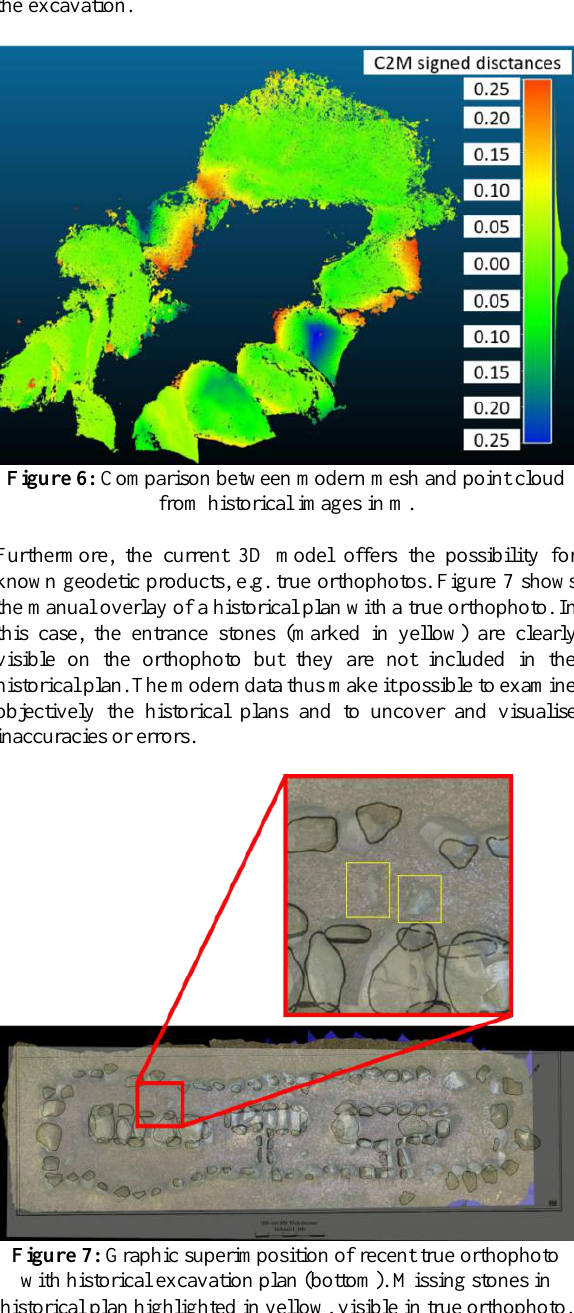
Figure 5: Modell calculated by SfM with historical images.